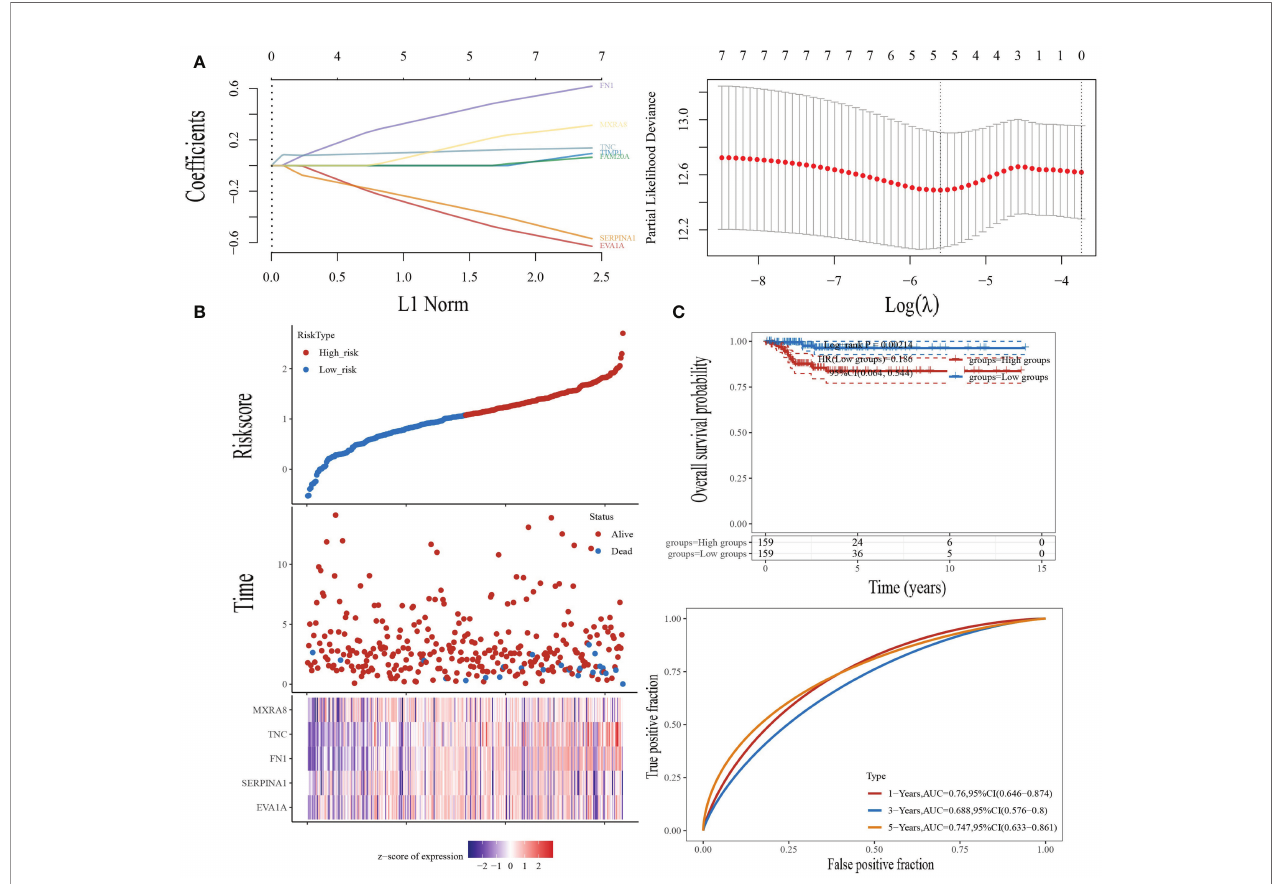
FIGURE 6 | Construction of the prognostic risk model. (A) LASSO analysis of related genes. (B) Risk scores, survival time, and survival status in the TCGA dataset. Top: scatterplot of risk scores from low to high; middle: scatterplot distribution of survival time and survival status corresponding to risk scores of different samples; bottom: heat map of gene expression in the prognostic model. (C) Top: K-M curves for high-risk patients and low-risk patients; bottom: ROC curves for one, three, and fi ve years for this risk model.